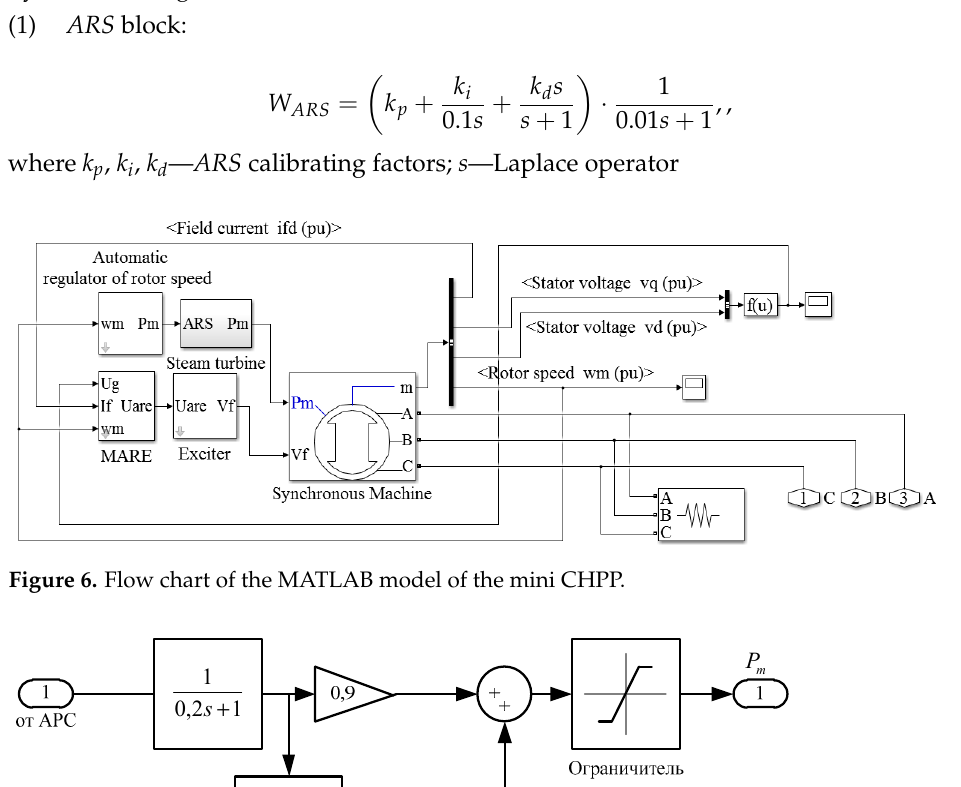
Figure 8. Current-voltage and power-voltage characteristics of the solar power plant model .